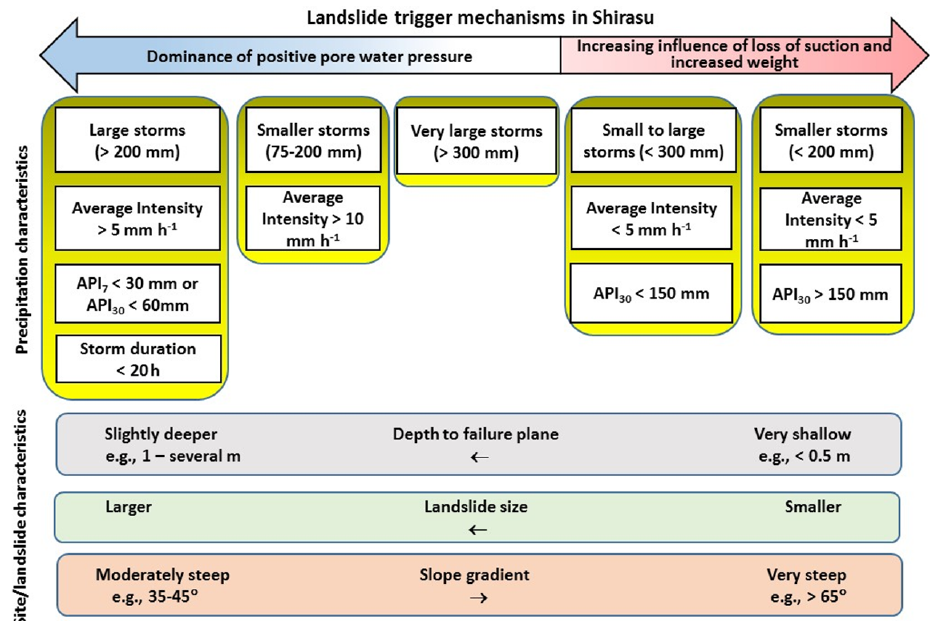
Figure 11. Diagram of empirical precipitation criteria that affect different landslide-triggering mechanisms in Shirasu deposits in southern Kyushu, together with slope gradient and resultant landslide